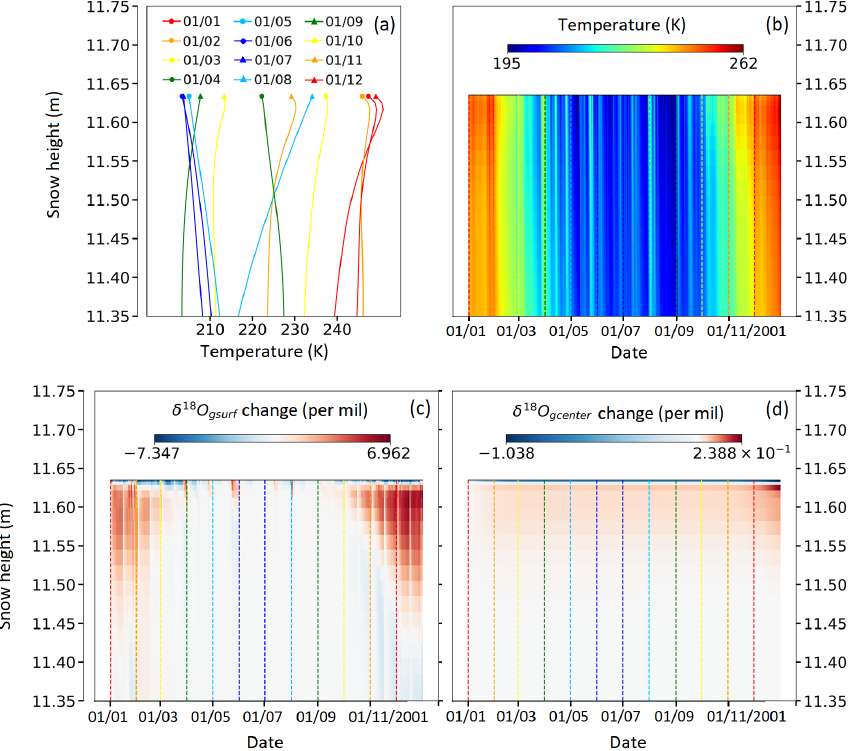
Figure 5. Simulation 3: evolution of temperature and δ 18 O values from January to December 2001. (a) Temperature profiles for the first day of each month; (b) temperature evolution in the snowpack; (c) δ 18 O change in the grain surface compartment; (d) δ 18 O change in the grain center compartment. Here, “ δ 18 O change” is defined as the difference between δ 18 O at t and at the beginning of the simulation for the selected layer.